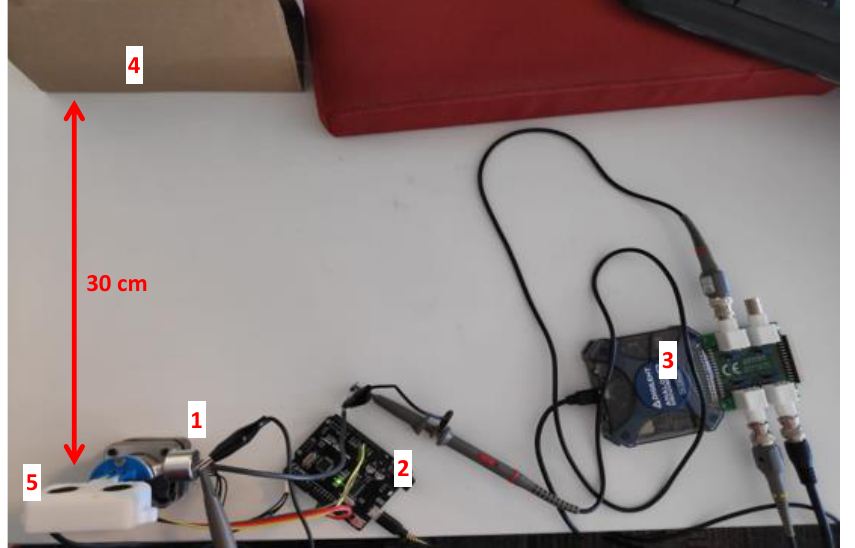
Figure 4. Experimental setup: 1—ultrasonic transmitter; 2—sensor controller; 3—function generator; 4—object;